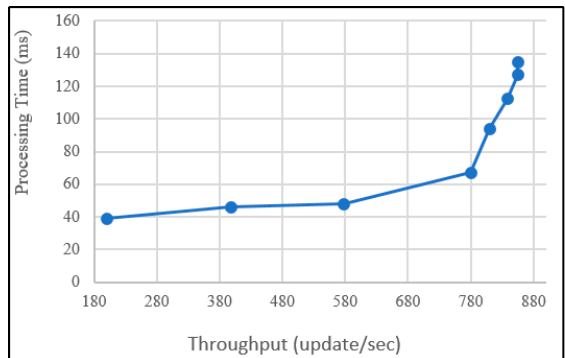
Figure 29. Resource utilization. Sensors 2019 , 19 , x FOR PEER REVIEW